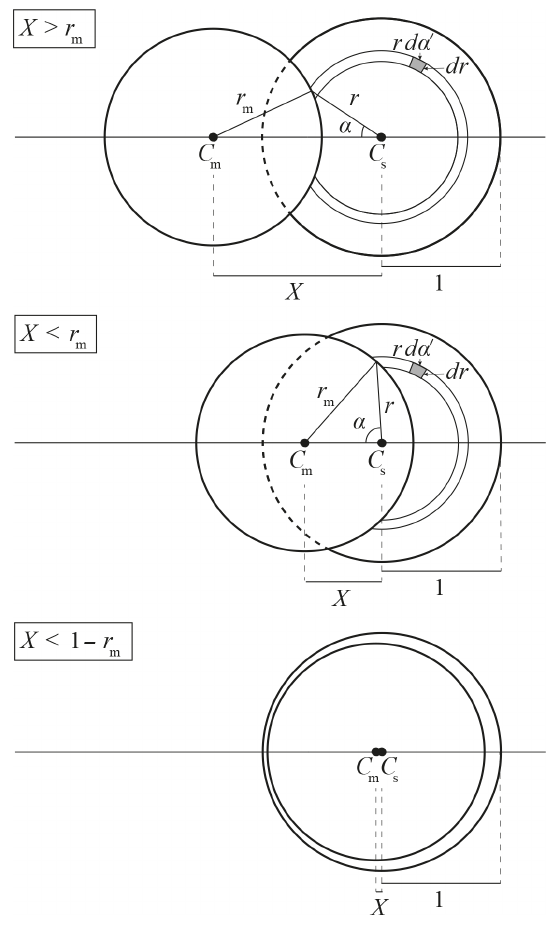
Figure 6. Sketches of the lunar disc (centred at C m ) occulting the solar disc (centred at C s ) during an annular solar eclipse. Here, r m < 1, where r m is the radius of the lunar disc and the solar disc radius equals 1. X is the distance between C m and C s . For X < r m + 1, the lunar disc occults the solar disc. The eclipse obscuration fraction f o increases with decreasing X . The annular phase occurs when X < 1 − r m (bottom sketch). Angle α is half the sector angle of the solar disc occulted at distance r by the lunar disc.